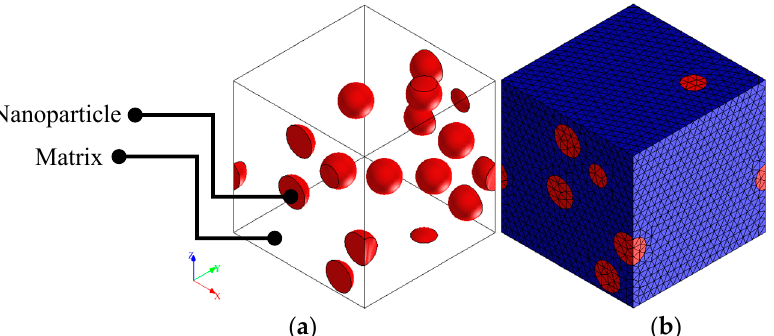
Figure 1. Micromechanical model of nanoparticle inclusion in the PVDF matrix ( a ) 3D model, ( b ) FE constructed mesh.